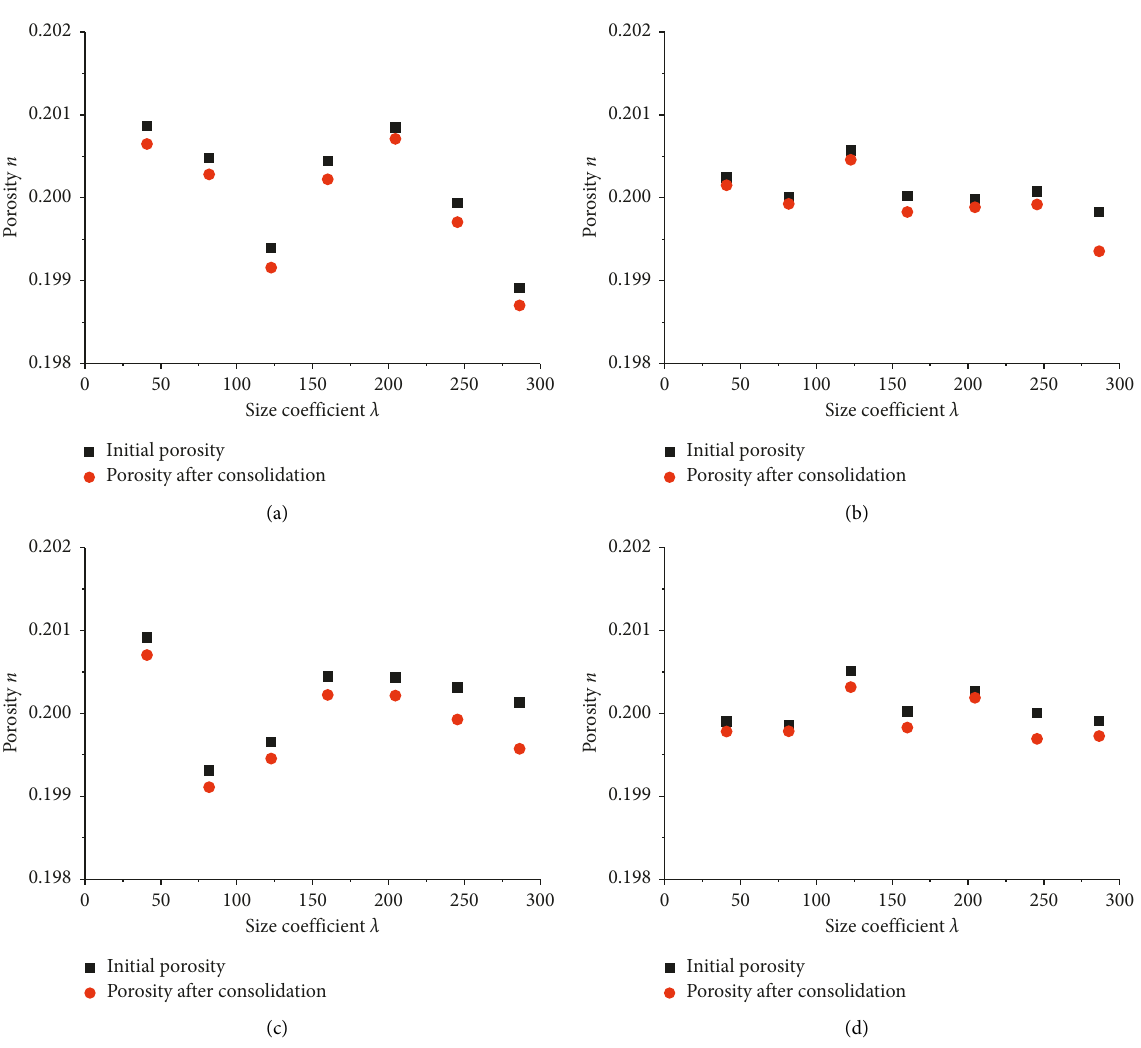
Figure 3: Porosity of RVEs with various heights and particle sizes after applying 20kPa confining pressure under different gravities. (a) RVE size related size effect at 0 g. (b) RVE size related size effect at 5g. (c) Particle size related size effect at 0g. (d) Particle size related size effect at 5